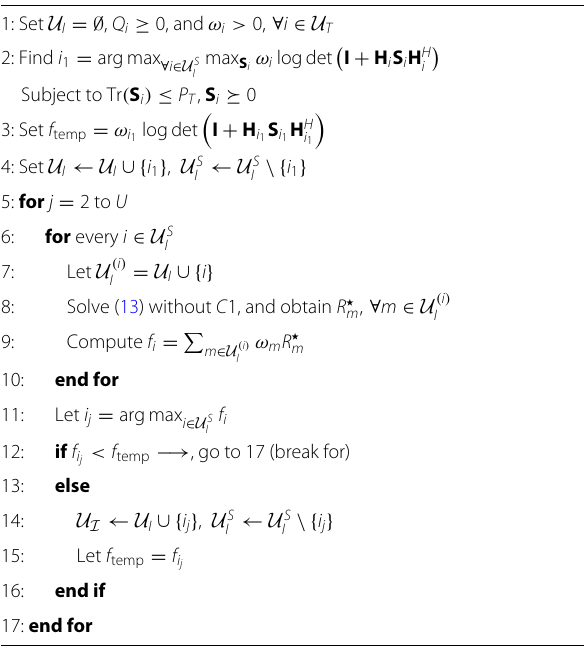
Table 4 Algorithm to obtain the set of information users U I